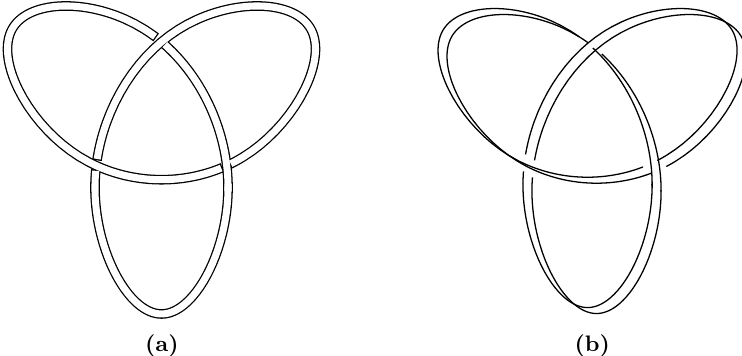
Figure 2. Two di(cid:11)erent framings of the trefoil knot. (a) is the simplest to visualize, the so called blackboard framing , where the normal vectors point all to the same vertical direction and the ribbon lies (cid:13)at on the projection plane. According to Calugareanu’s theorem [58], the self-linking number in this case is the writhe number of the knot ( w = 3 here). (b) shows another choice of framing having 4 extra twists on the ribbon (in general, any framing can be drawn as a blackboard framing with a number of extra twists). Note that each twist may increase or decrease the self-linking number, depending on whether it is a positive or negative twist. In particular, the self-linking number can always be set to zero by an appropriate number of twists | this de(cid:12)nes the so called canonical framing